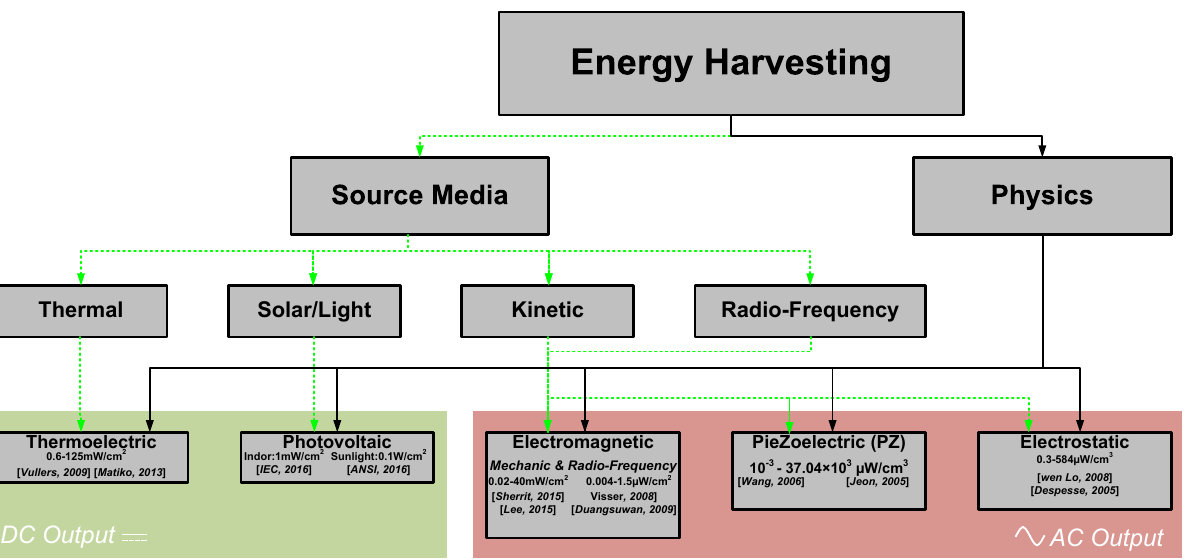
Figure 3. Taxonomy of the energy harvesting techniques with respect to the physical effect and input energy [17,18], highlighting common power densities for domestic environment reported in the literature; thermoelectric [19,20], photovoltaic [21,22], electromagnetic [23,24] (mechanical), [25,26] (radio-frequency), and electrostatic